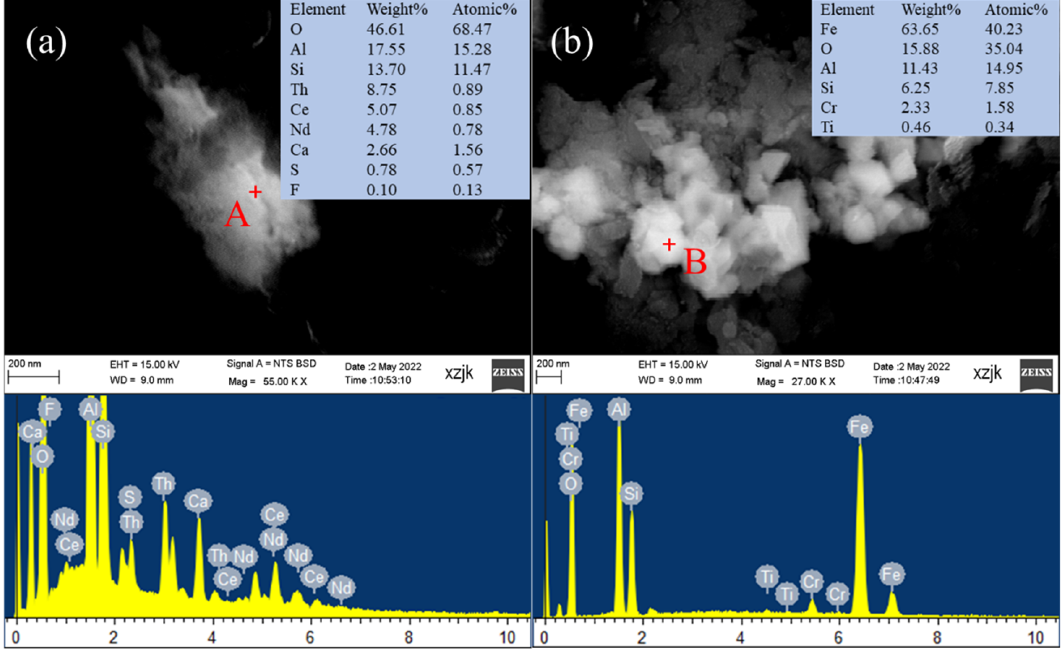
Figure 4. Back-scattered SEM images of different coal gangues and EDS patterns of the selected points. ( a ) clay mineral; ( b ) almandine. points. ( a ) clay mineral; ( b )